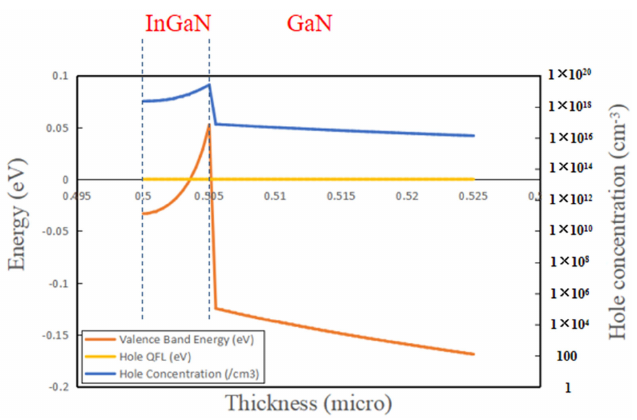
Figure 8. Simulation results on the valence band energy and hole concentration at the InGaN/GaN by Silvaco TCAD tools.